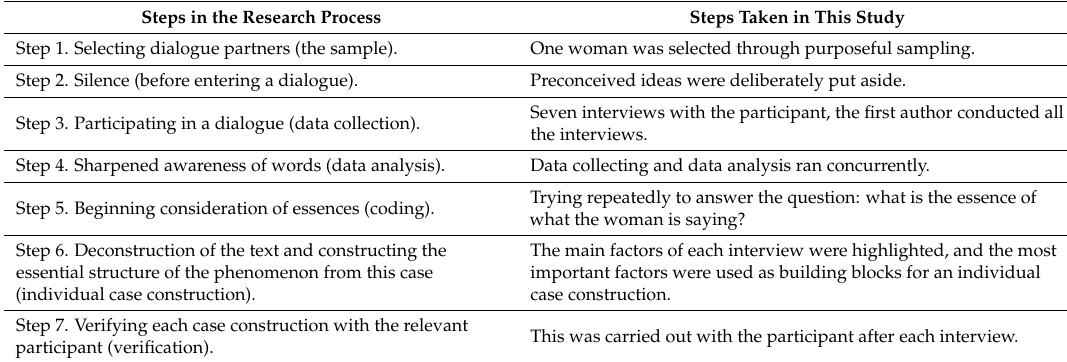
Table 3. The 12 research steps of the Vancouver-School and steps taken in this